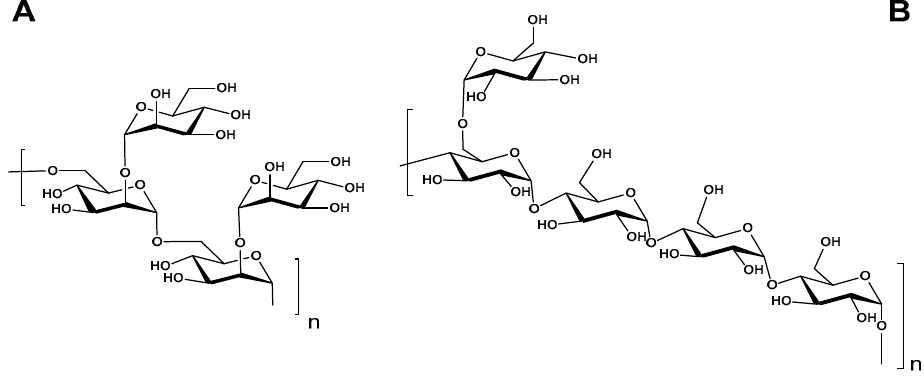
Figure 4. Proposed structures of BCG-1 ( A ) and BCG-2 ( B ) purified from BCG-PSN.